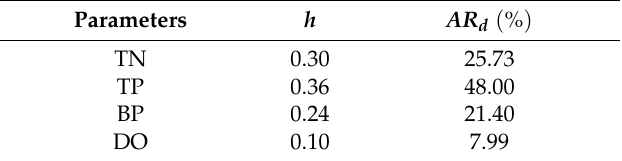
Table 3. The quantitative fit criteria of the state variables in the calibrated